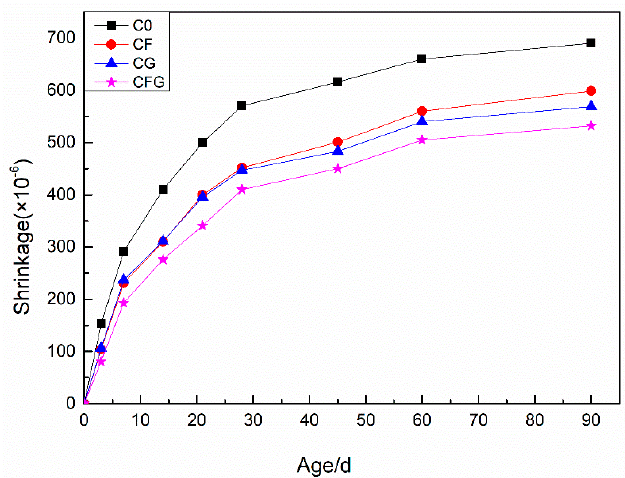
Figure 7. Drying shrinkage rate of specimens at different ages.